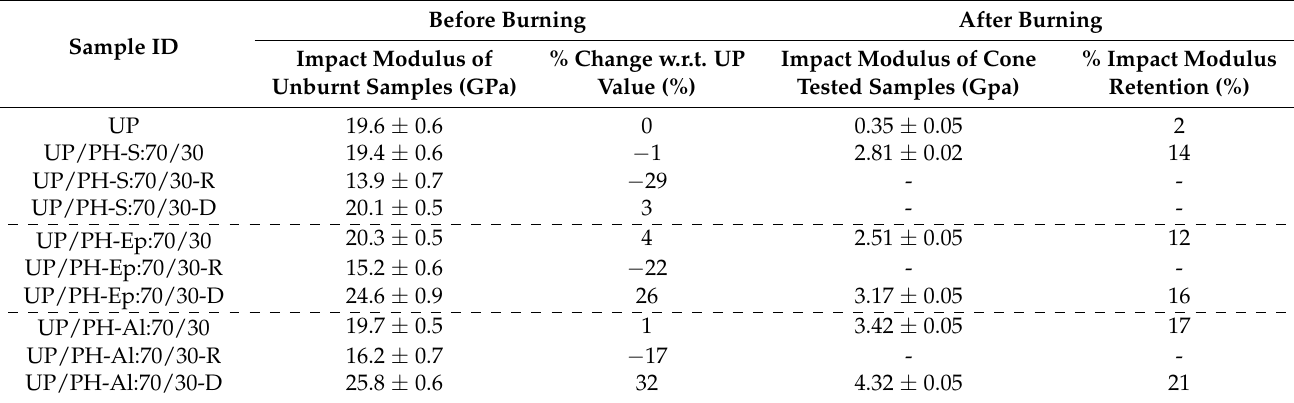
Table 5. Impact modulus of GFRC of UP and UP/PH samples with FRs before and after